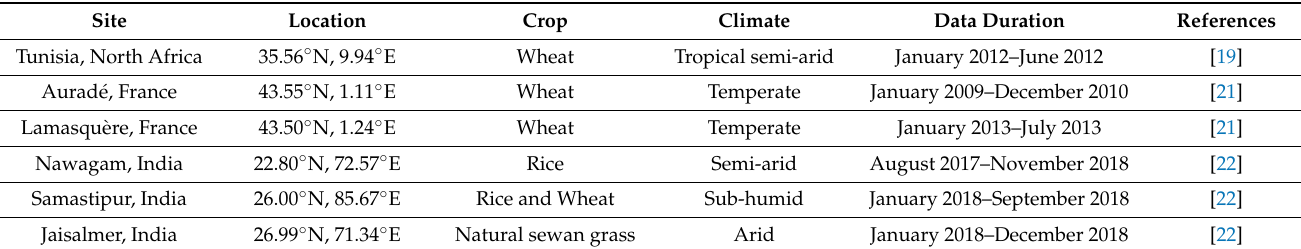
Figure 1. Study sites. Table 1. Details of the sites used in the study.